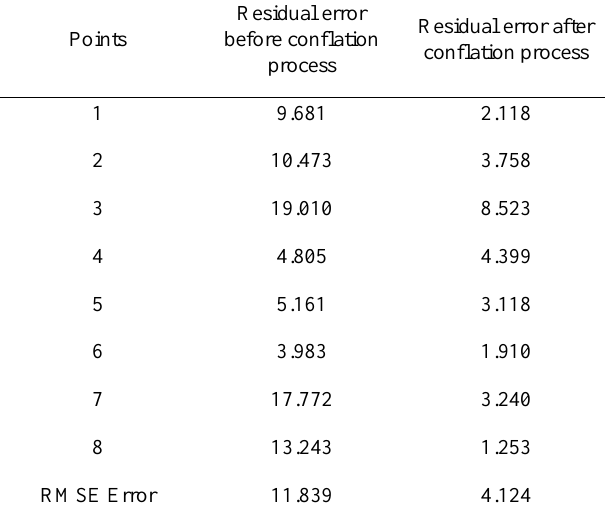
Table 1: Estimating the residual and RMSE errors before and after the conflation